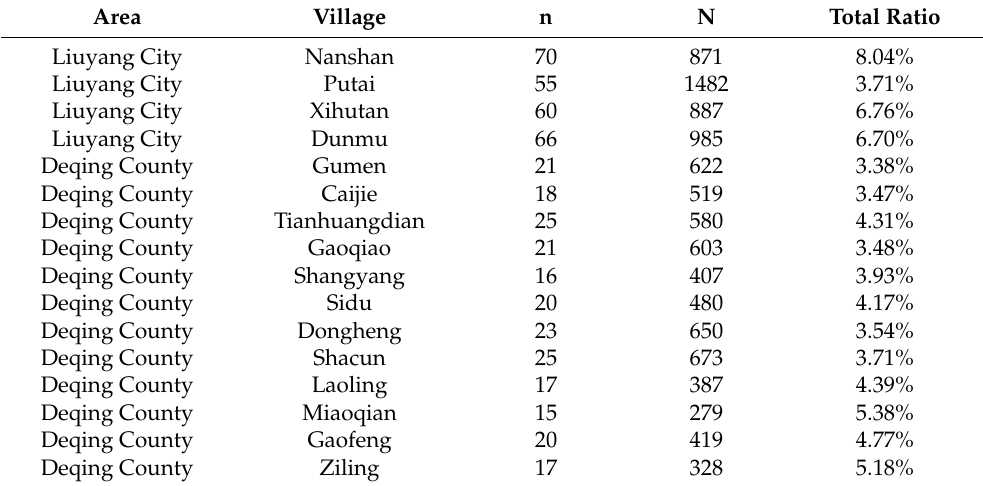
Table 1. Sample size and total ratio of each village.